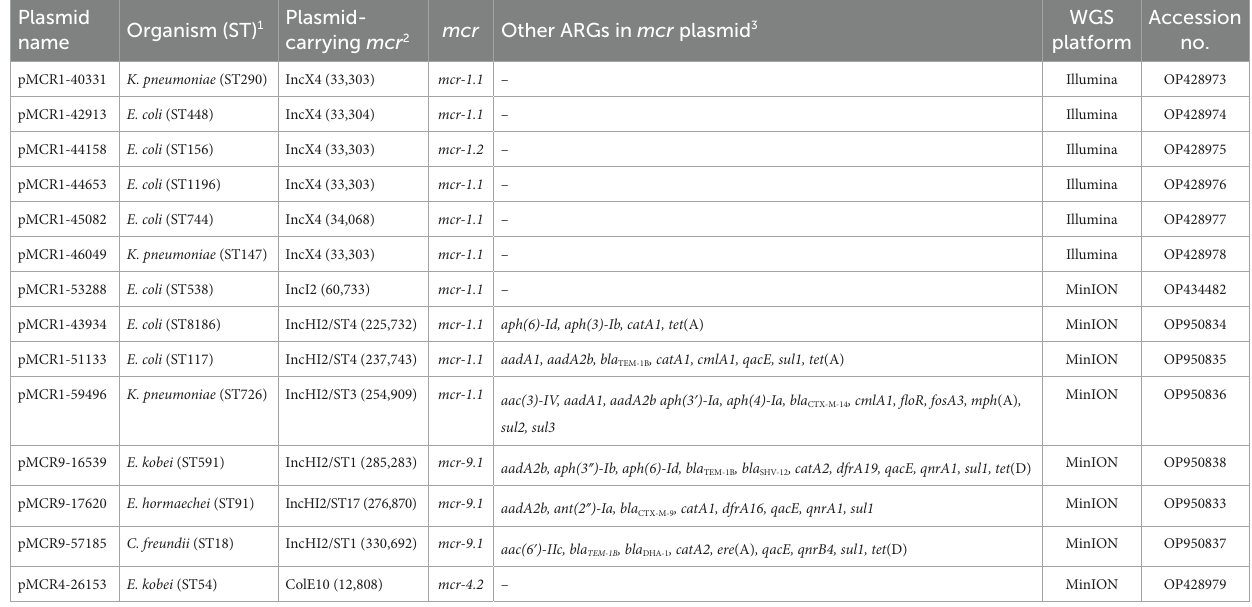
TABLE 1 The characteristics of sequenced mcr -encoding plasmids. Plasmid